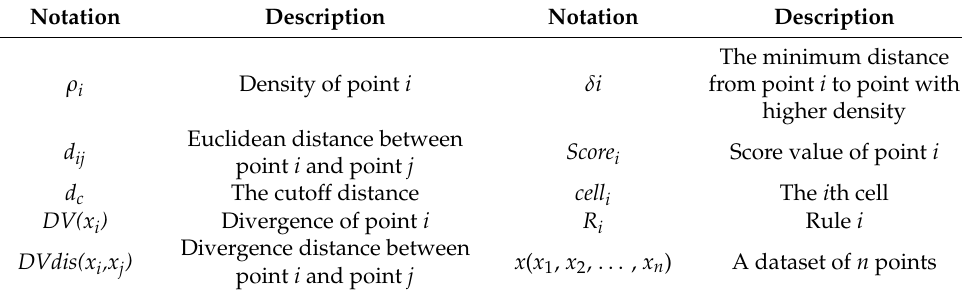
Table 2. The main